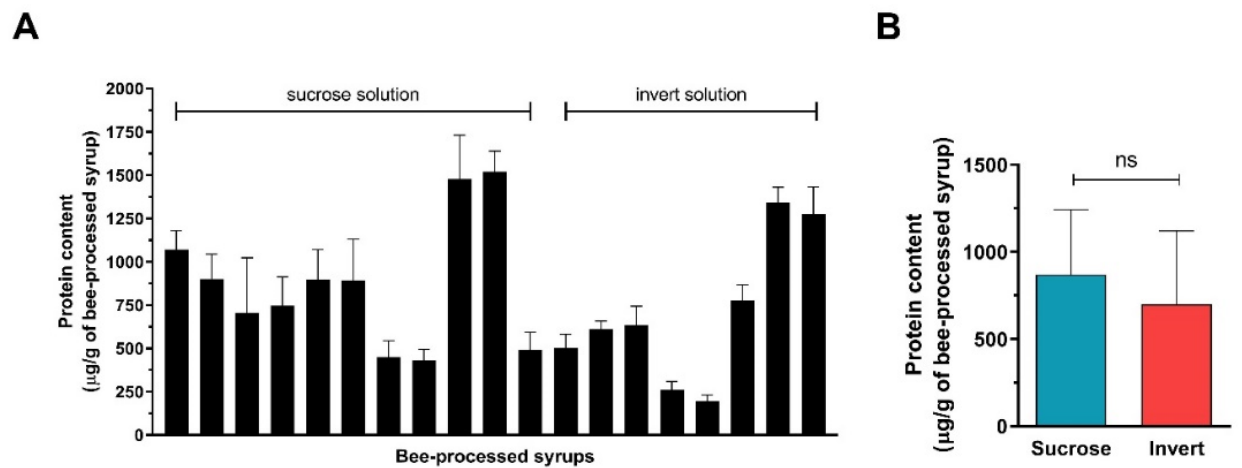
Figure 6. Total protein contents of bee-processed syrups. Protein content was determined using the Quick Start Bradford protein assay. ( A ) Protein content in individual bee-processed syrup after processing sucrose solution ( n = 11) or invert sugar syrup ( n = 8). ( B ) Average protein content in both analyzed groups of bee-processed